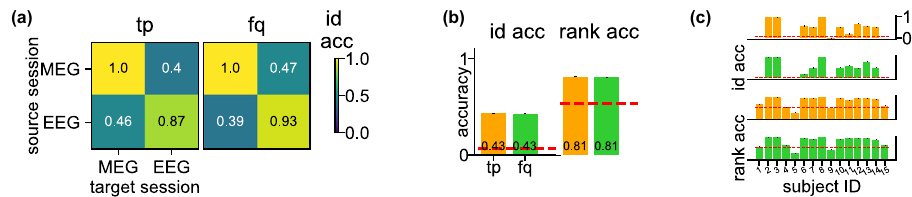
Fig. 6 Consistent tp and fq for cross-modality identi fi cation on MEG-EEG data. a Heat maps of the cross-modality identi fi cation accuracy using the two features on MEG-EEG data. MEG and EEG data for the same individual were recorded on different days. For one identi fi cation run, the features of each individual were computed using randomly sampled trials ( N = 200) from both the source and target session. Each grid represents the average accuracy across 15 individuals and 100 identi fi cation runs. The within-task accuracy (diagonal entries) was computed using the same source-target splitting procedure as on the Harry Potter data to avoid data leakage. b Average cross-modality identi fi cation accuracy and rank accuracy for each feature. Within- modality accuracy (MEG vs. MEG, EEG vs. EEG) were excluded in the computation. Error bars are the SEs across cross-modality sessions ( N = 2), individuals ( N = 15), and identi fi cation runs ( N = 100) and are invisible due to small values. The red dashed lines are the chance level for the identi fi cation accuracy ( ¼ 1 ) and rank accuracy ( ¼ 16 ). c Identi fi cation (upper two rows) and rank (lower two rows) accuracy on MEG-EEG data by individual. Within- 15 30 modality accuracy is excluded in the computation. Error bars are the SEs across cross-modality sessions ( N = 2) and identi fi cation runs ( N = 100) and are invisible due to small values. The red dashed lines are the same as in ( b ). These results indicate that tp and fq are consistent even when different neuroimaging modalities were used in the source and target